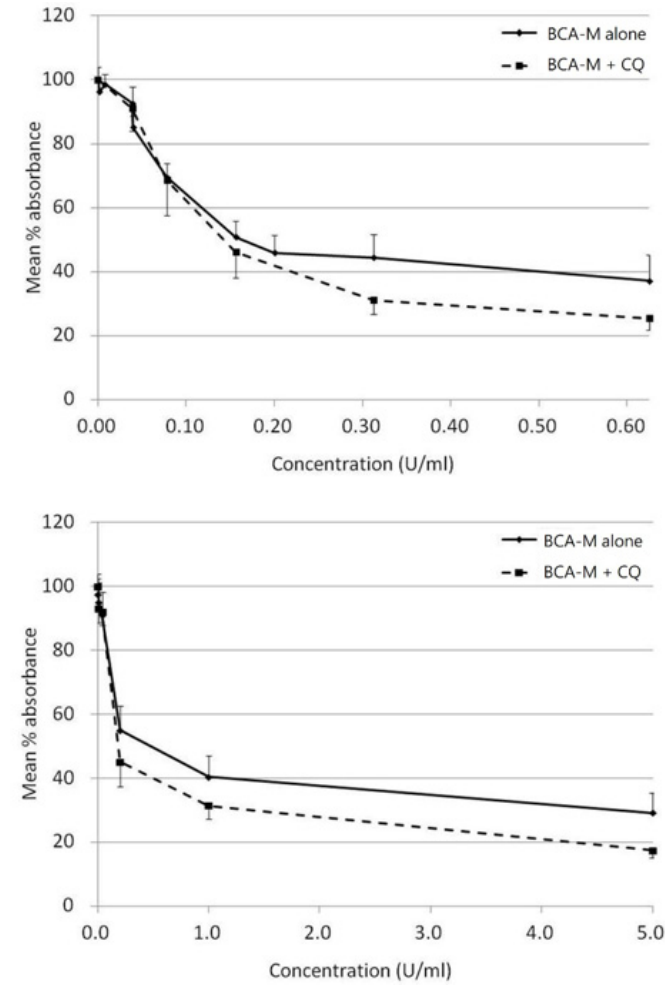
Figure 9. Growth inhibitory e ff ect of BCA-M was enhanced synergistically by its combination to CQ on HeLa and SiHa human cervical cancer cells. The results of cell proliferation assay were represented by the mean % absorbance and S.D. ( A ) For SiHa cells, BCA-M was 2-fold serially diluted from 0.625 U / mL with or without combination to CQ starting at 6.25 µ M and serially diluted along with BCA-M to maintain a constant ratio between the drugs. ( B ) For HeLa cells, constant drug ratio approach was also used with the starting concentration of BCA-M at 5 U / mL and CQ at 25 µ M. In both cases, the combination of CQ enhanced the growth inhibitory e ff ect of BCA-M. Table 2. IC 50 values and combination index (C.I.) for the treatment of BCA-M and chloroquine.